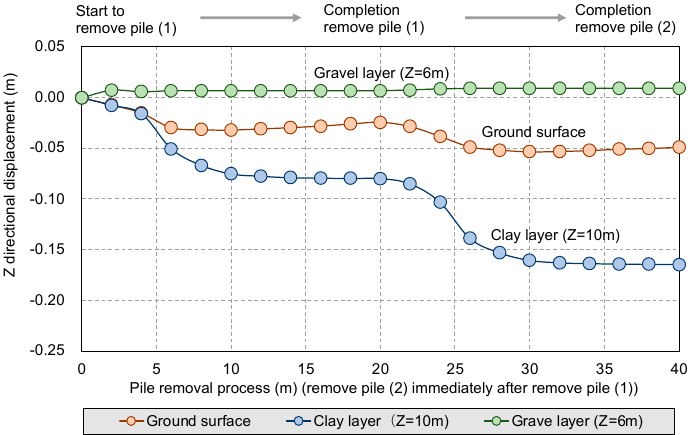
Figure 8. Amount of subsidence of the surrounding ground in the process of forming two extraction holes of removed piles.